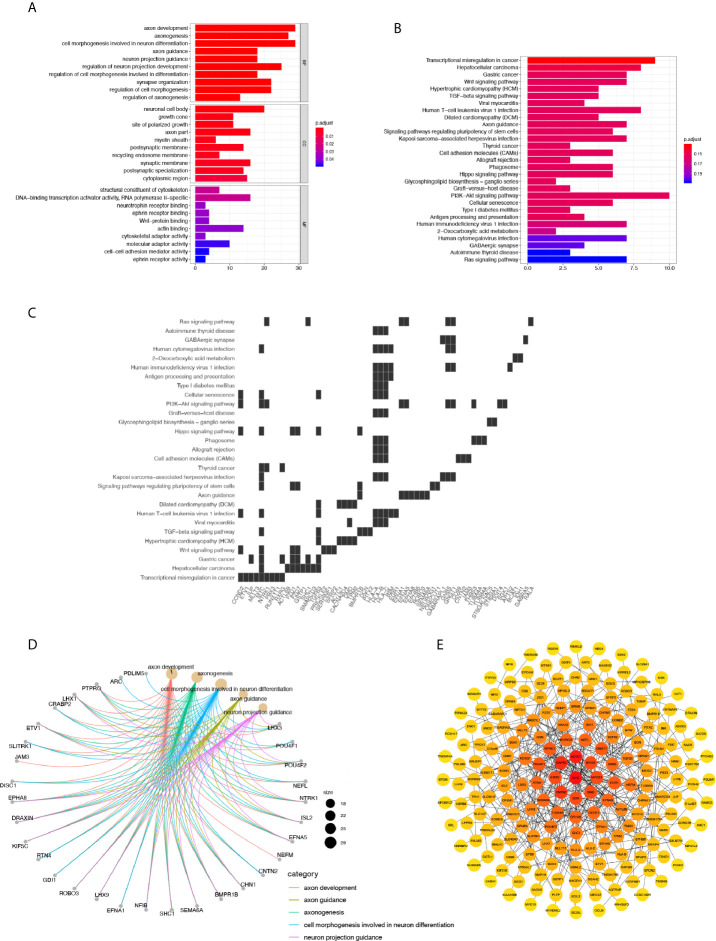

(A) GO annotation of cluster 6. (B) Gene net plot showing the common genes in multiple GO entries. (C) Heatmap showing the genes involved in each pathway. 6. (D) KEGG annotation of cluster 6. (E) Protein-Protein Interaction network of marker genes in cluster 6, where the node with the highest degree of interaction is darker and located in the center.